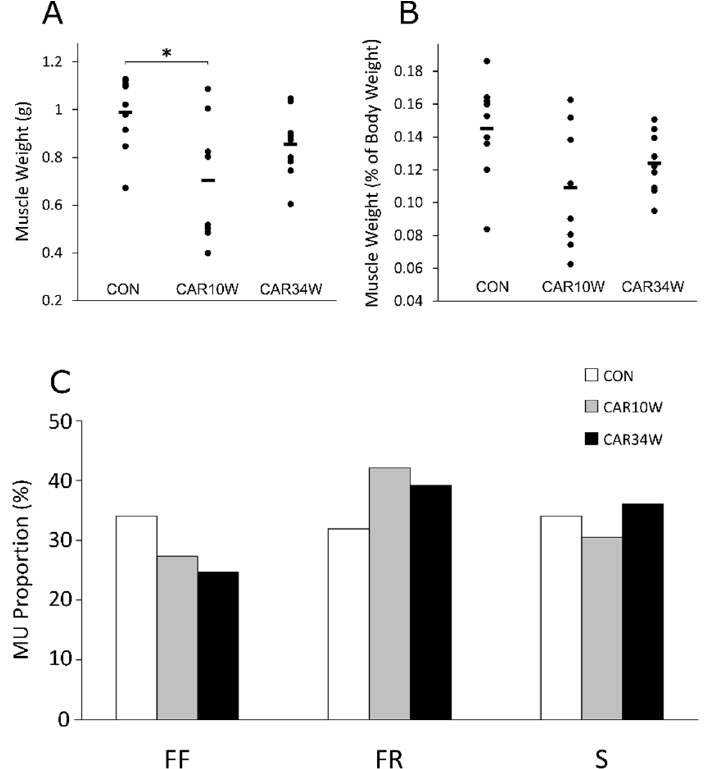
Figure 1. Medial gastrocnemius absolute and normalized muscle weights and distribution of motor units in CON, CAR10W, and CAR34W rats. ( A ) Absolute muscle weight (g). ( B ) Muscle weight normalized to body weight (%). ( C ) Percentage of different types of MUs. Mean ± SD values are presented in ( A , B ). The asterisks above the bars denote a significant difference ( p < 0.05; one-way ANOVA Bonferroni-corrected post hoc test). CON refers to the non-supplemented group, CAR10W to the 10 weeks supplemented group, and CAR34W to the 34 weeks supplemented group. Mus: motor Table 1. Contractile properties of sampled motor units of the left medial gastrocnemius muscle in CON ( n = 6), CAR10W ( n = 8), and CAR34W ( n = 8) rats. Motor Units Properties